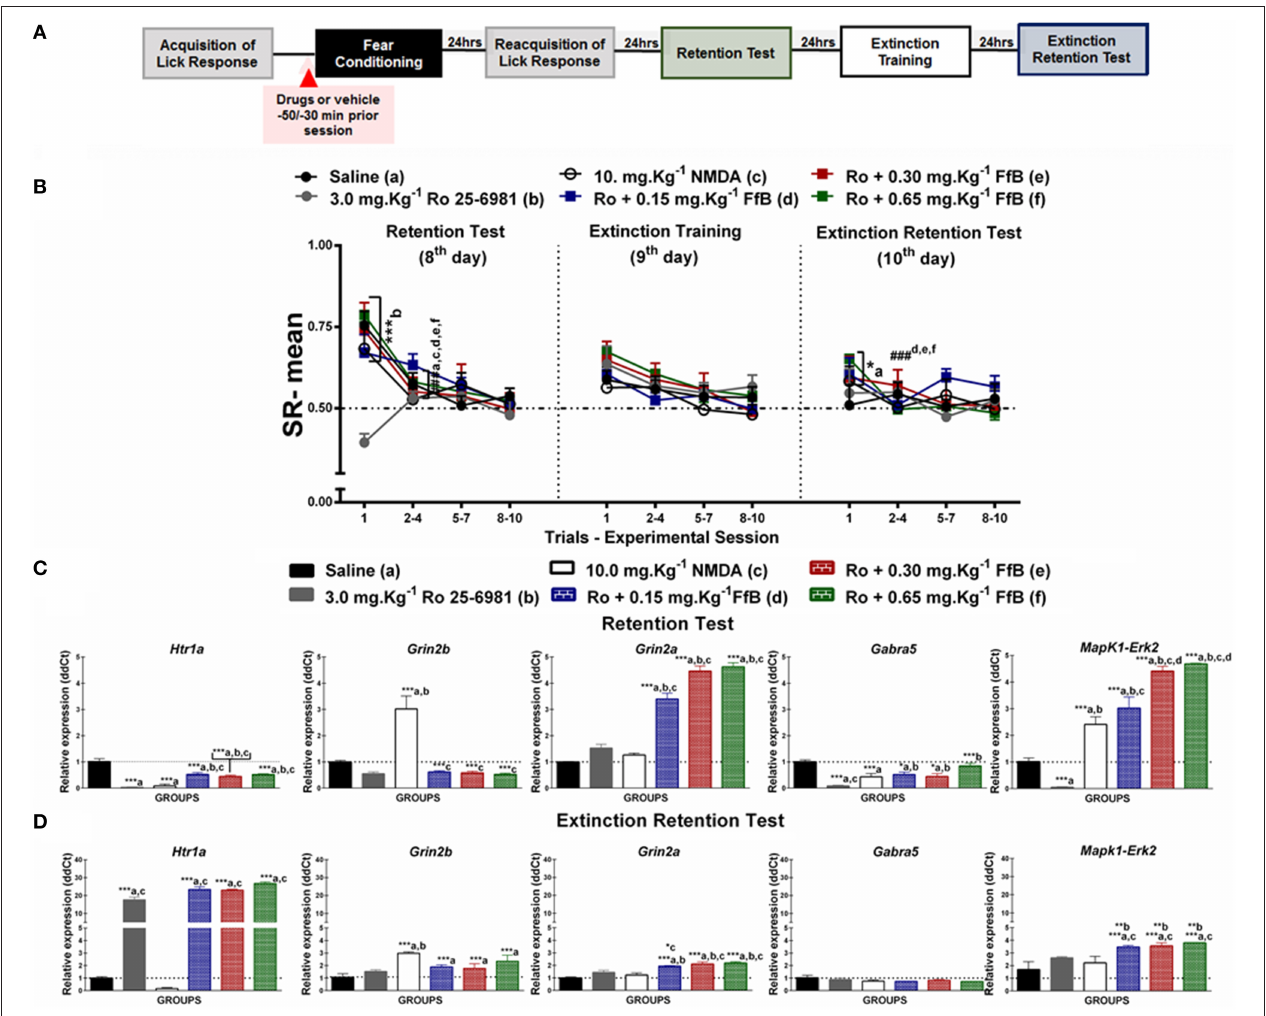
FIGURE 4 | (A) Timeline illustrating the time points of drug administration and brain removal. (B) Mean SR of licking behavior in the test session (8 th day, n = 20 /group), extinction training (9 th day, n = 10 /group) and the extinction retention test (10 th day, n = 10 /group). The first point indicates the mean SR for the 0.9% saline, 3.0mg.Kg − 1 Ro25-6981, 10mg.Kg − 1 NMDA, and Ro25-6981 + FfB (0.15 mg.Kg − 1 FfB, 0.30mg.Kg − 1 FfB, or 0.65mg.Kg − 1 FfB) subgroups. The